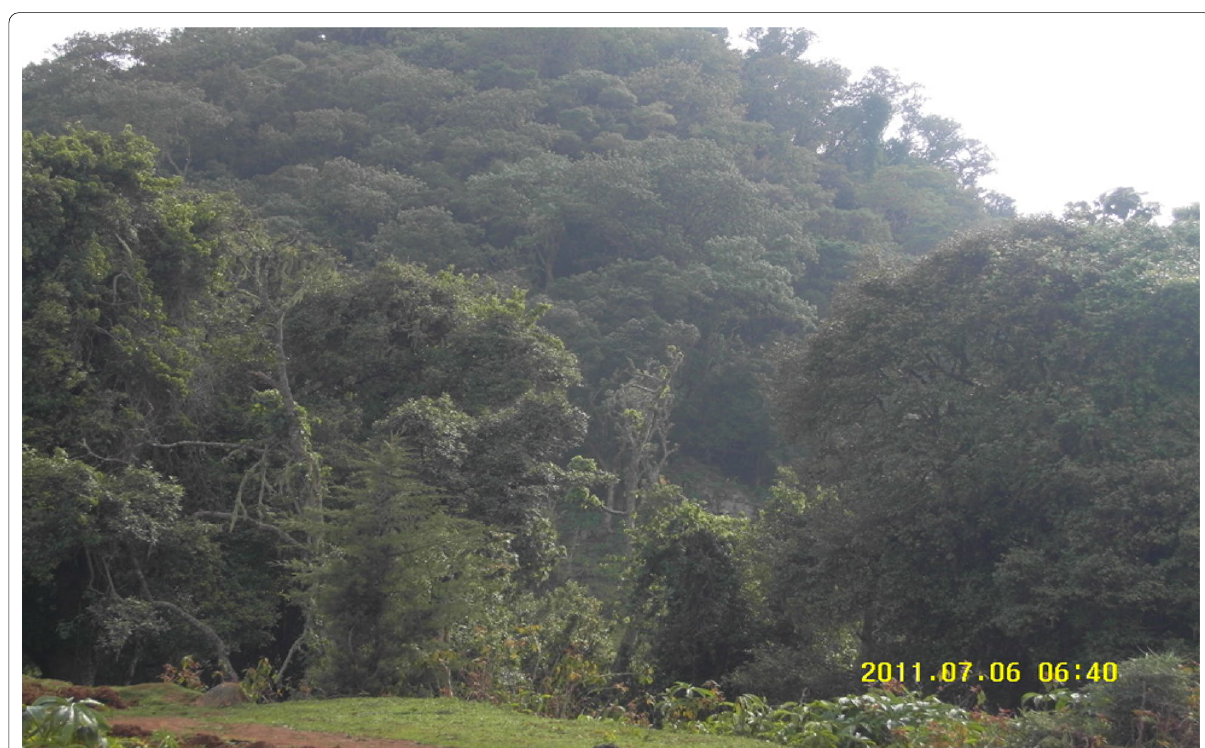
Fig. 2 Traditionally protected trees in Nagasa of